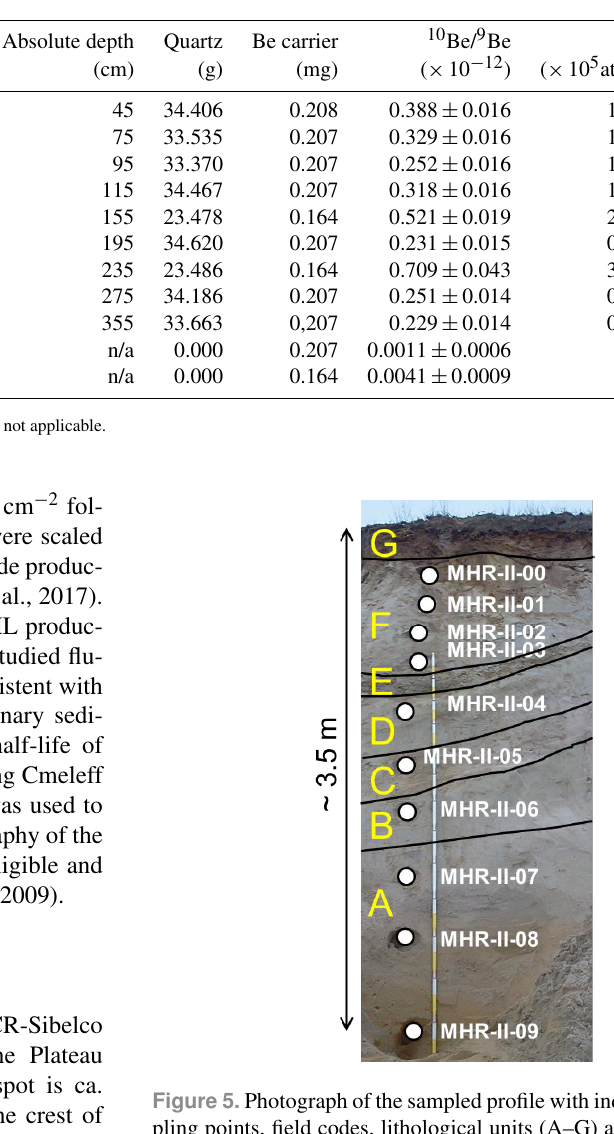
Table 1. Analytical results from the in situ-produced 10 Be analysis. The depth profile is located at 50.95 ◦ N and 5.63 ◦ W at an altitude of